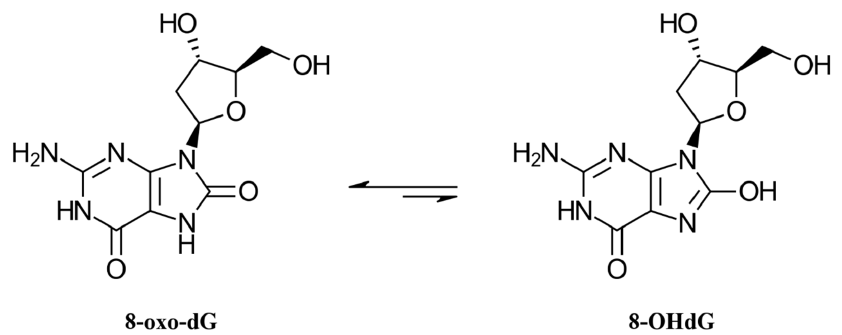
Figure 1. Structure of 8-oxo-7,8-dihydro-2 ′ -deoxyguanosine (8-oxodG) and its tautomer 8-OHdG.